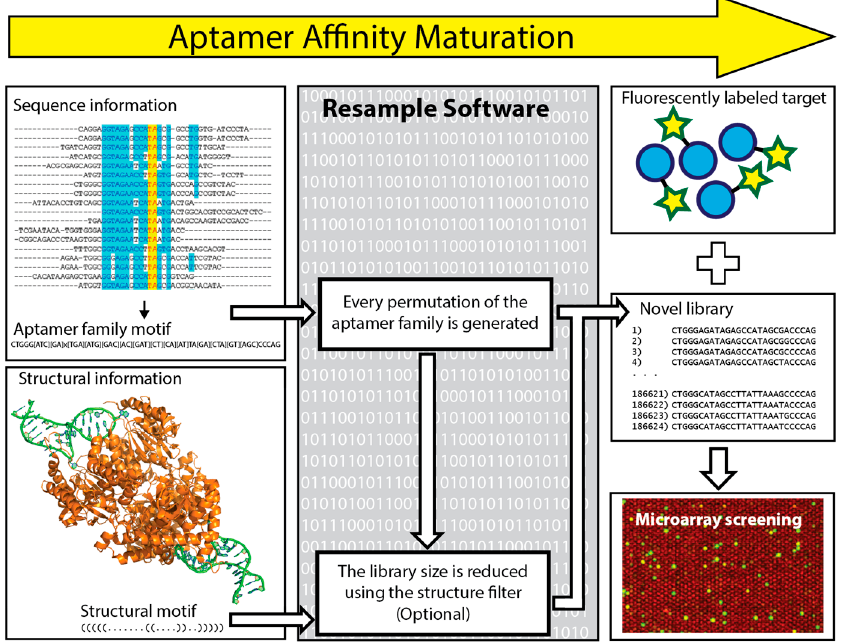
Figure 6. The aptamer affinity maturation process. The yellow arrow designates the aptamer affinity maturation process, in which data from a SELEX experiment is utilized by bioinformatic software to Create a novel aptamer library which undergoes a microarray screening process. Sequence information and, if available, folding information (optional) from a SELEX experiment is used as input for the resample software. Resample outputs a novel focused aptamer library that is small enough to fit on a DNA microarray. The microarray is incubated with a fluorescently labeled target before washing and scanning to measure the binding strength of all aptamers. Figure adapted from Kinghorn et al. [118].